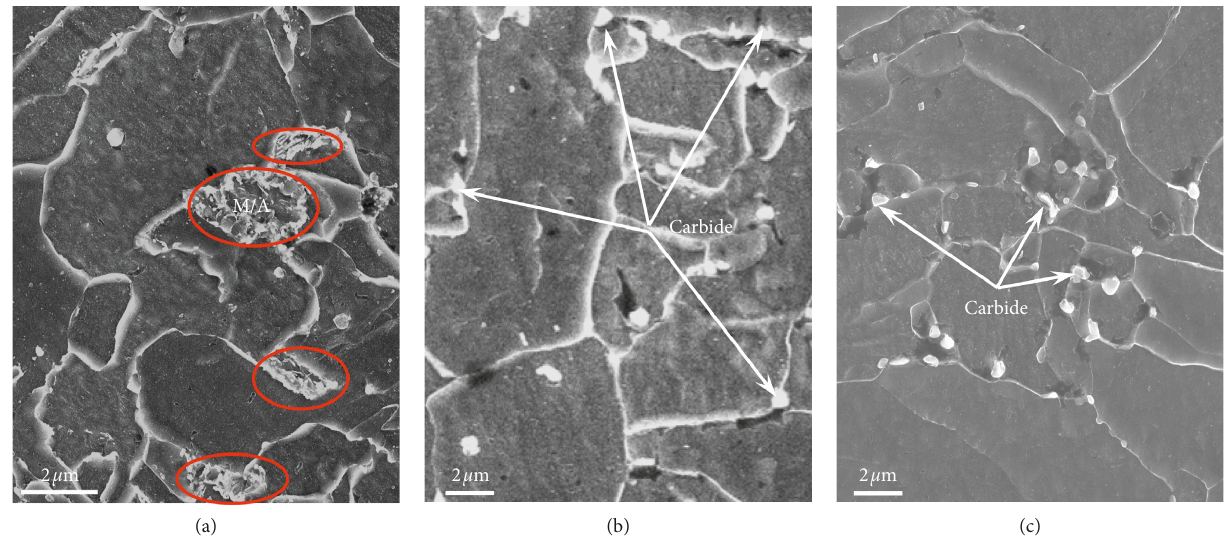
Figure 7: SEM micrographs of Bend C tempered at different temperatures: (a) 550 ° C; (b) 620 ° C; (c) 680 ° C.